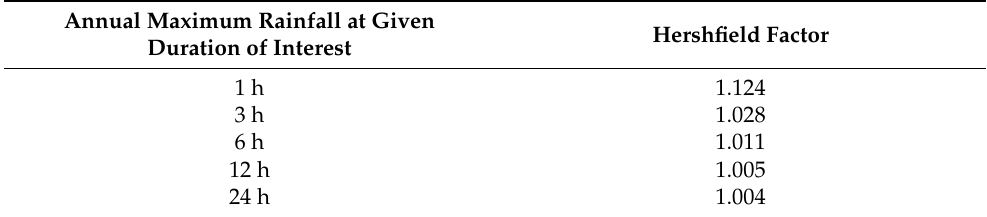
Table 2. Hershfield (Sampling Adjustment) Factors for the annual rainfall maxima at the different durations observed by the historical SIMN